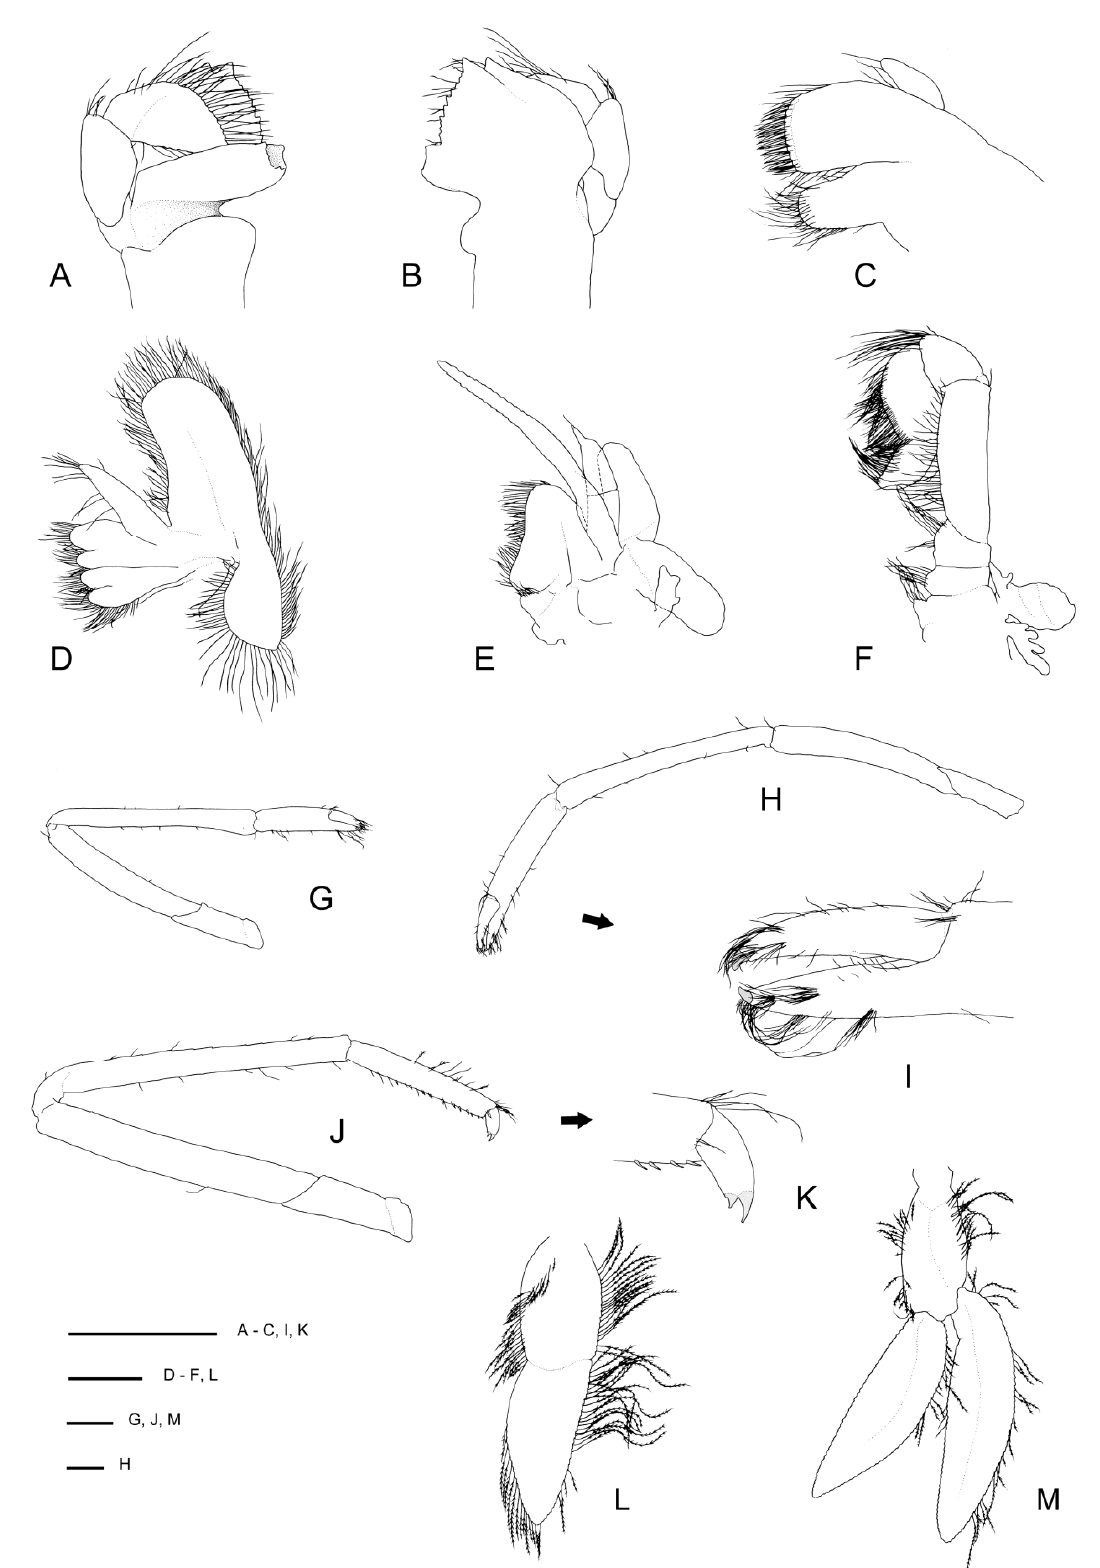
Figure 10. Spongicoloides novaezelandiae Baba, 1979 [20], F (NIWA 40567). ( A ) Left mandible, inner view. ( B ) Same, outer view. ( C ) Left maxillule, outer view. ( D ) Left maxilla, outer view. ( E ) Left Mxp1, outer view. ( F ) Left Mxp2, outer view. ( G ) Right P1, lateral. ( H ) Right P2, mesial. ( I ) Same, fingers, mesial. ( J ) Right P4 or P5, lateral. ( K ) Same, dactylus, lateral. ( L ) Right first pleopod, mesial. ( M ) Right second pleopod, mesial. Scale bars = 1